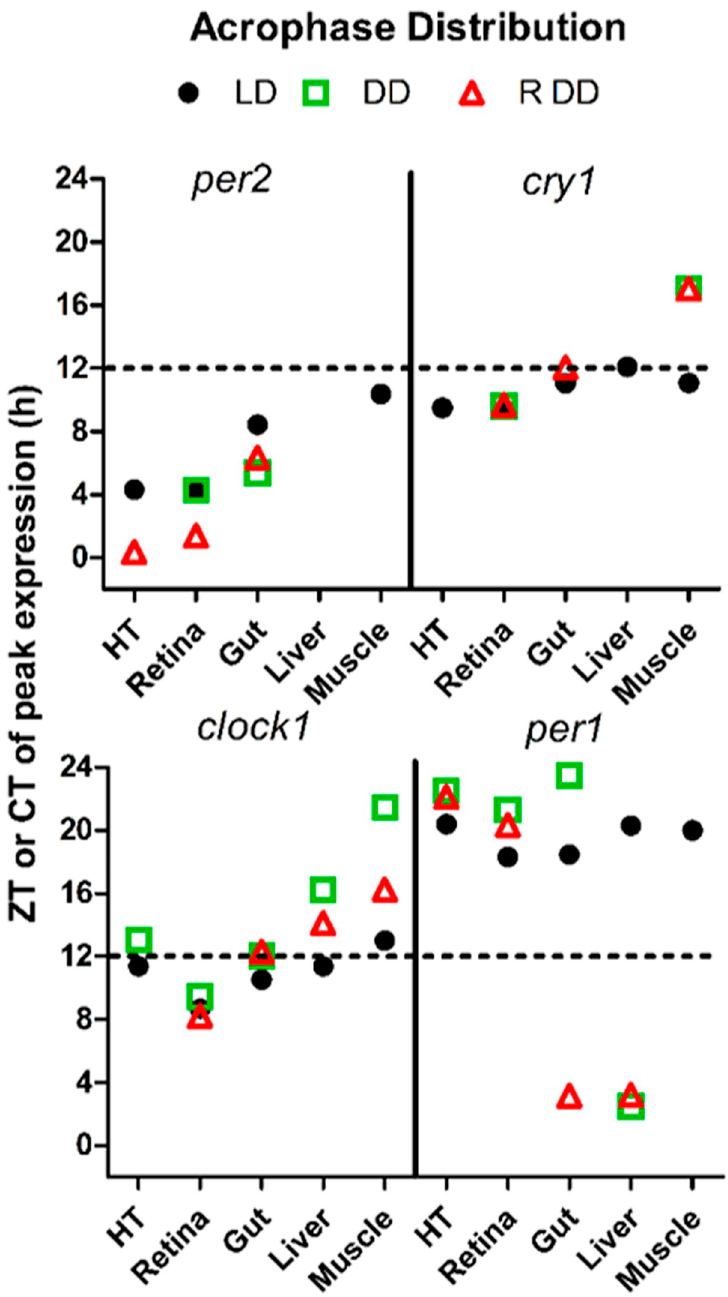
Fig 2. Acrophase distribution of per2, cry1, clock and per1 from turbot. Fish kept under schedule feeding time and LD (black points) or DD (green square) and under free-running conditions (red triangle). Only the acrophases of the genes that showed significant rhythms as confirmed by cosinor analysis were represented. The cry1 acrophase was shifted under DD in muscle, meanwhile the per1 acrophase shifted under free-running conditions in gut and under DD and schedule feeding and free running conditions in liver. The dashed line on the Y axis shows the boundary between the light phase and the dark phase. ZT0 is defined as the time when lights are switched on.